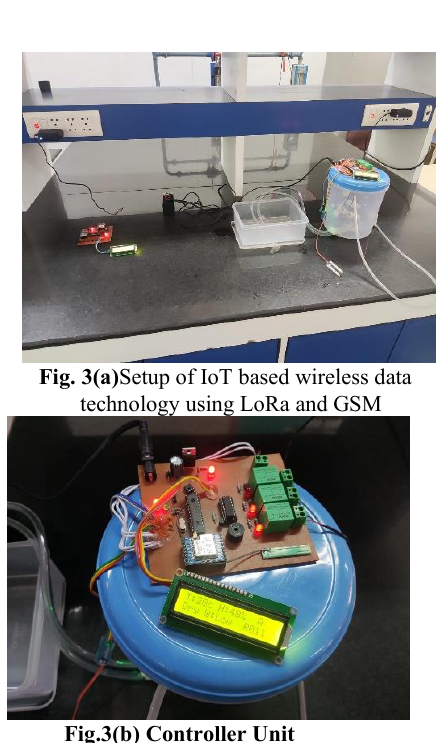
Fig.3(b) Controller